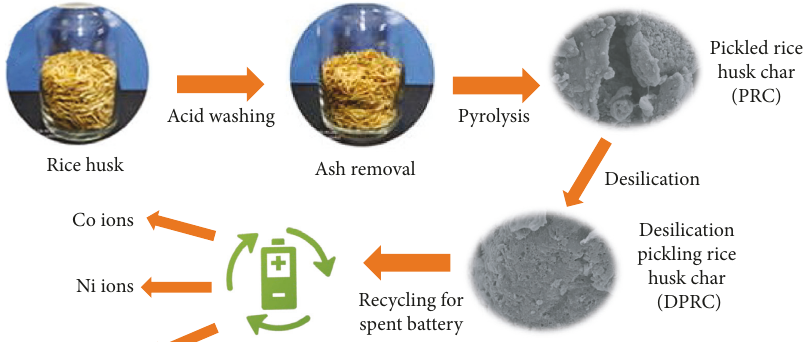
Figure 1: Synthesis and application of